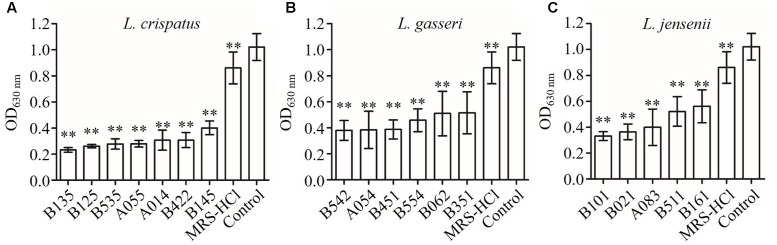
Inhibition effects of CFS from different Lactobacillus strains on Candida albicans growth in YPD broth at 24 h after inoculation. (A)
L. crispatus, (B)
L. gasseri, (C)
L. jensenii. Each bar is the mean ± SD from three independent experiments. ∗∗P < 0.01 compared to control by Student’s t-test.